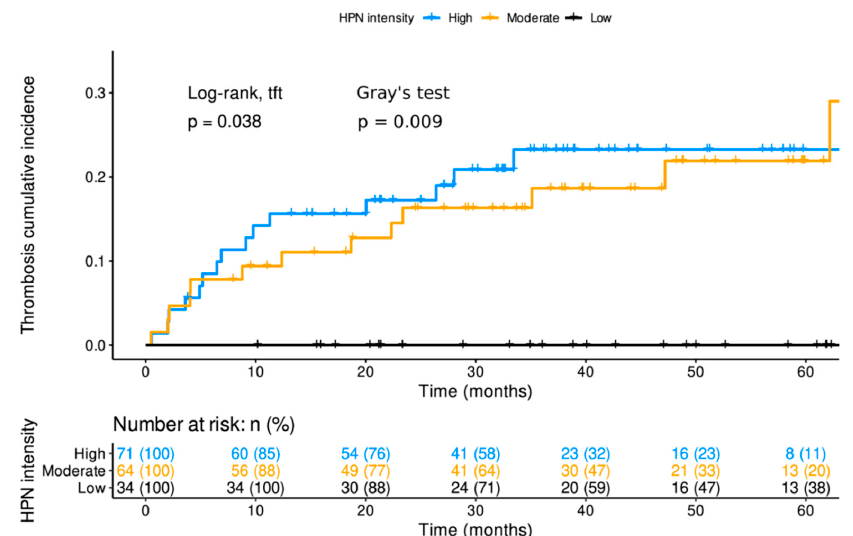
Figure 3. Cumulative incidence of thrombosis of localized patients at diagnosis according to Hepsin staining. The cumulative incidence of thrombosis is shown for the three groups of patients with different hepsin levels at diagnosis. The time on the X-axis corresponds with the months of follow-up since diagnosis. The Log-rank test for trends and the Gray’s test give information on the degree of significance of the differences between the three groups of patients. At the bottom, the patients who may suffer from thrombosis after a given time from the start of follow-up are shown. p : p -value; tft: test for trends; HPN: Hepsin; n (%): number of patients (percentage). Table 4. Multivariate Fine and Gray regression model for the cumulative incidence of thrombosis in localized patients at diagnosis. Multivariate Fine and Gray Regression for Cumulative Incidence of Thrombosis